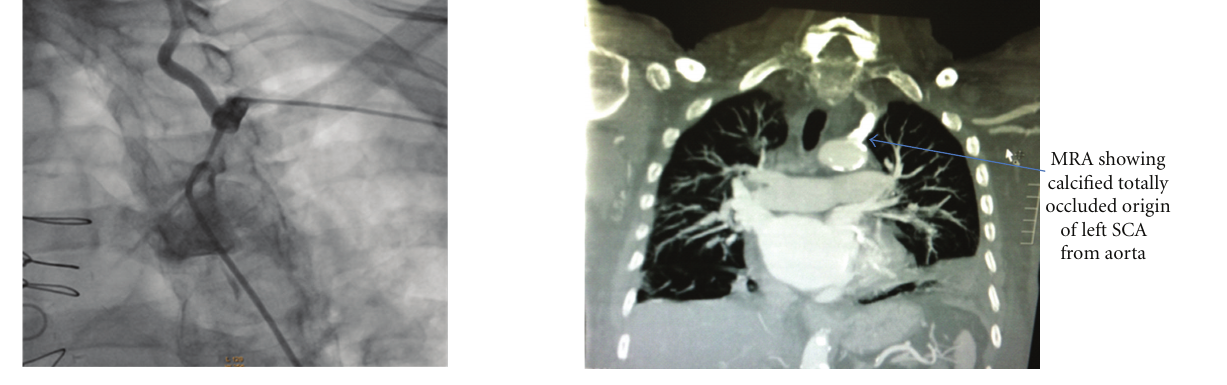
Figure 3: Magnetic resonance angiography showing completely occluded proximal left subclavian